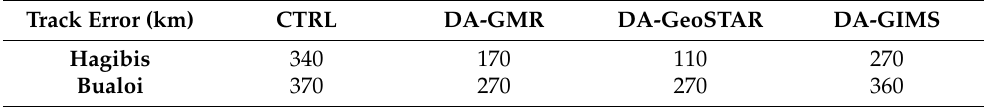
Table 9. The average error of the predicted track. Track Error (km) CTRL DA-GMR DA-GeoSTAR DA-GIMS Hagibis 140 100 Bualoi 210 160 140 190 Table 10. The 72-h error of the predicted track. Track Error (km) CTRL DA-GMR DA-GeoSTAR DA-GIMS Hagibis 340 170 110 270 Bualoi